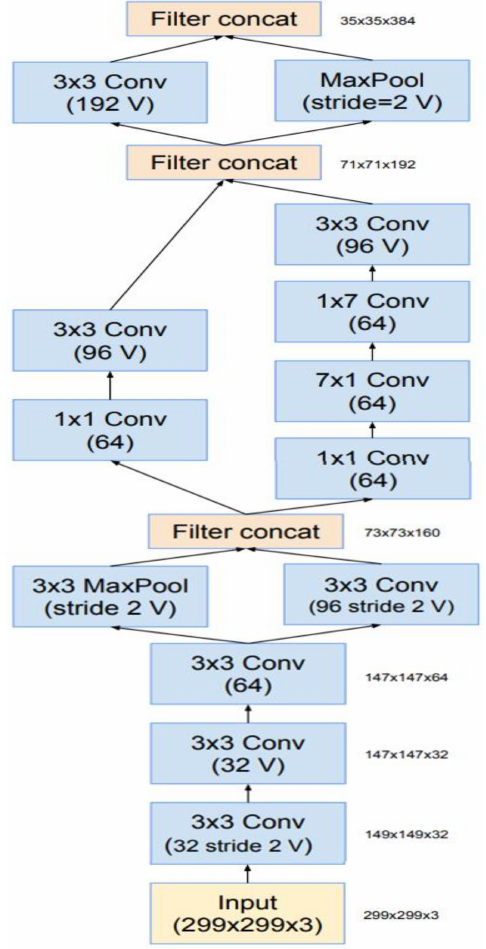
Figure 7. The schema for the stem of the pure Inception-v4 and Inception-ResNet-v2 networks. These are the input parts of those networks.